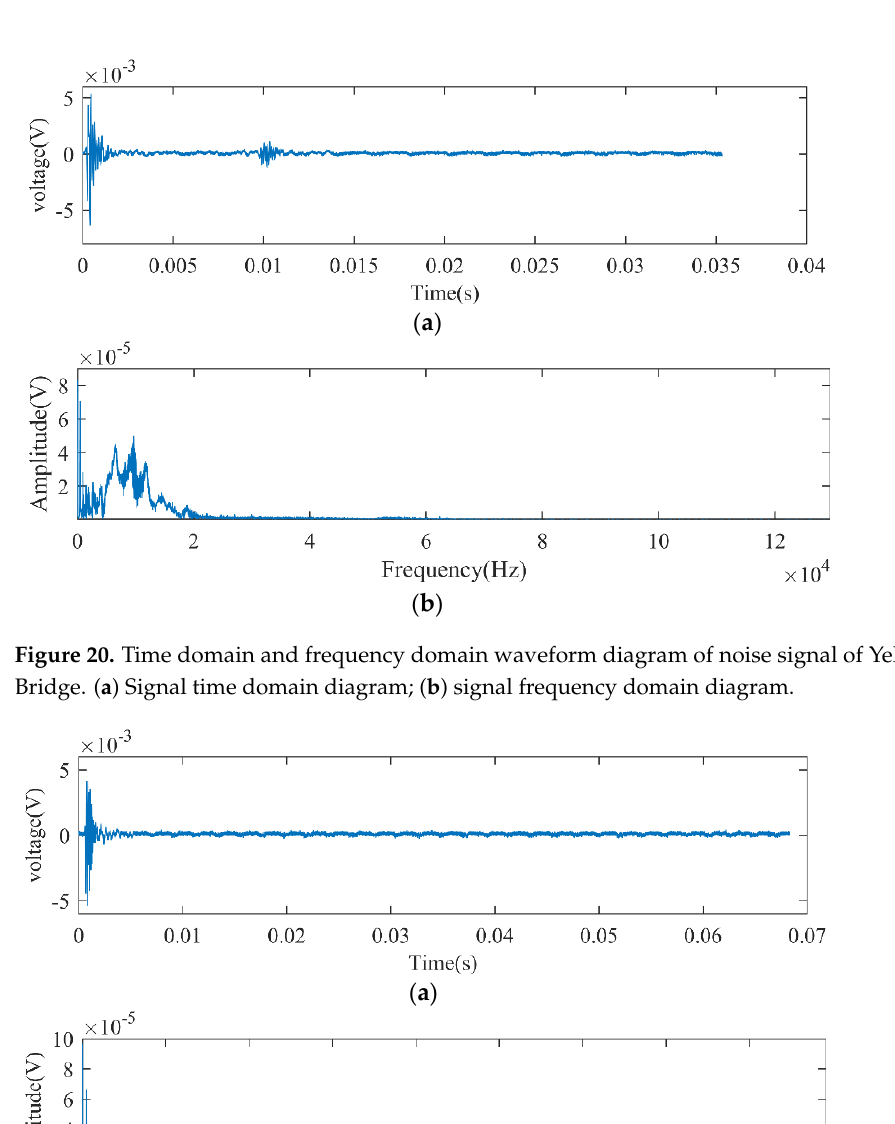
Figure 19. Time domain and frequency domain waveform diagram of noise signal of Yangma Island Bridge. ( a ) Signal time domain diagram; ( b ) signal frequency domain diagram.